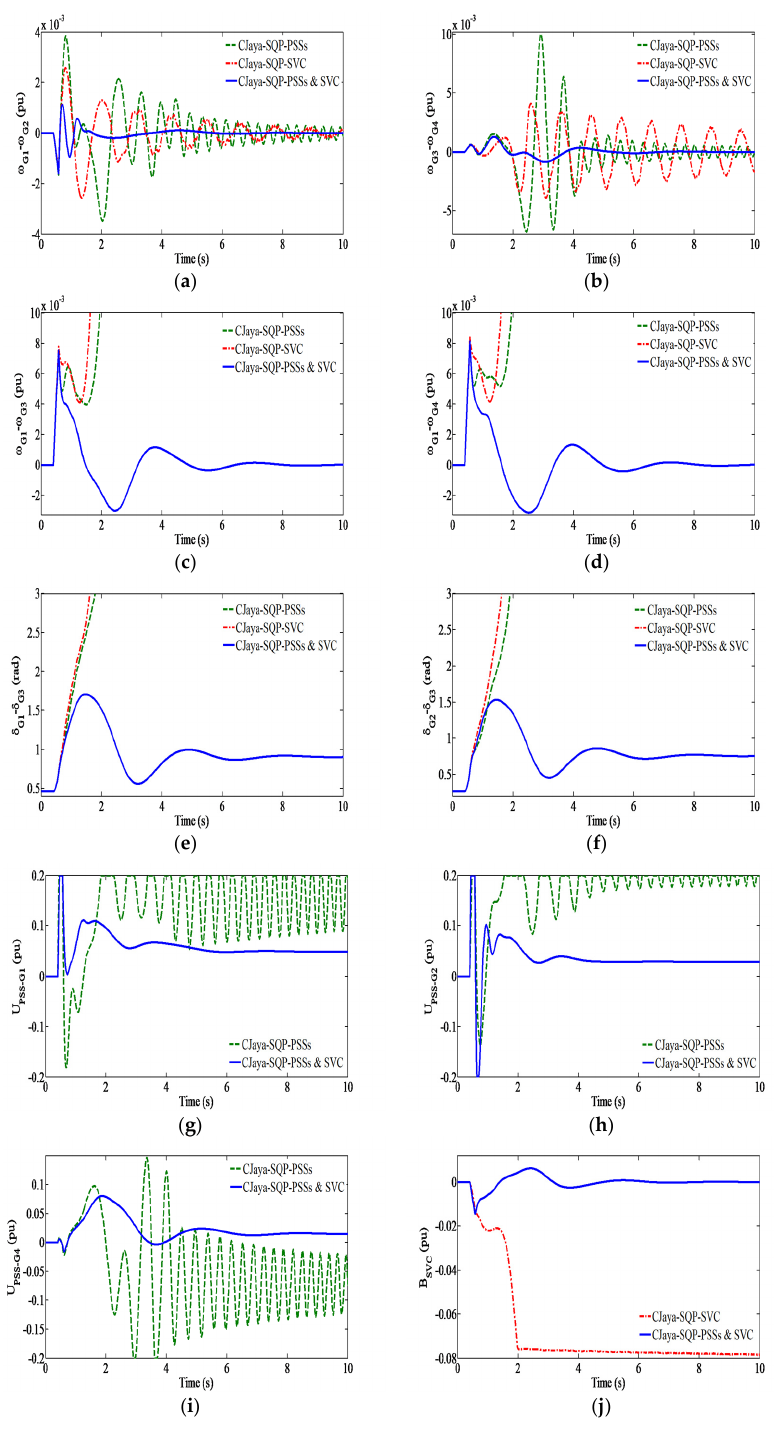
Figure 19. Power systemdynamic responses for scenario III: ( a ) Speed deviation response of G1-G2; ( b ) Speed deviation response of G3-G4; ( c ) Speed deviation response of G1-G3; ( d ) Speed deviation response of G1-G4; ( e ) Rotor angle response of G1-G3; ( f ) Rotor angle response of G2-G3; ( g ) PSS output signal response at generator G1; ( h ) PSS output signal response at generator G2; ( i ) PSS output signal response at generator G4; and ( j ) SVC susceptance response.